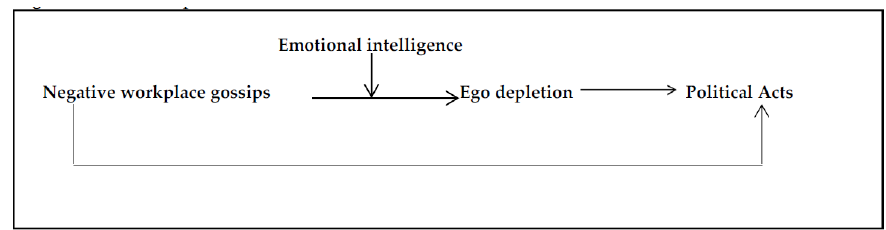
Figure 2. The Conceptual Model.